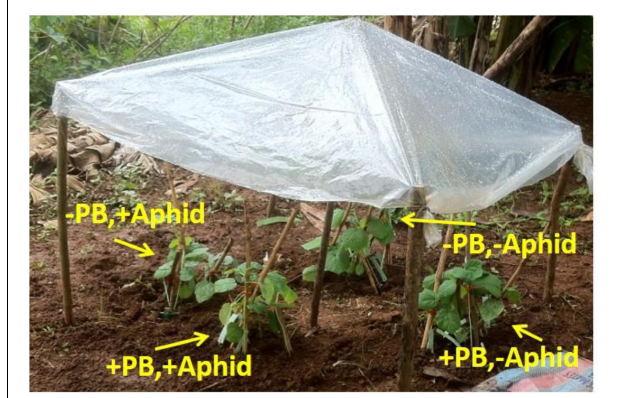
FIGURE 1 | Experimental set up in the field to test preference of different ant species of aphid honeydew or okra pearl bodies. The image shows set up of one replicate. The plants are placed in four groups around the ant colony; each group includes all five plant varieties. Group 1: (–)Aphid (+)PB, Group 2: (–)Aphid (–)PB, Group 3: (+)Aphid (+)PB, Group 4: (+)Aphid